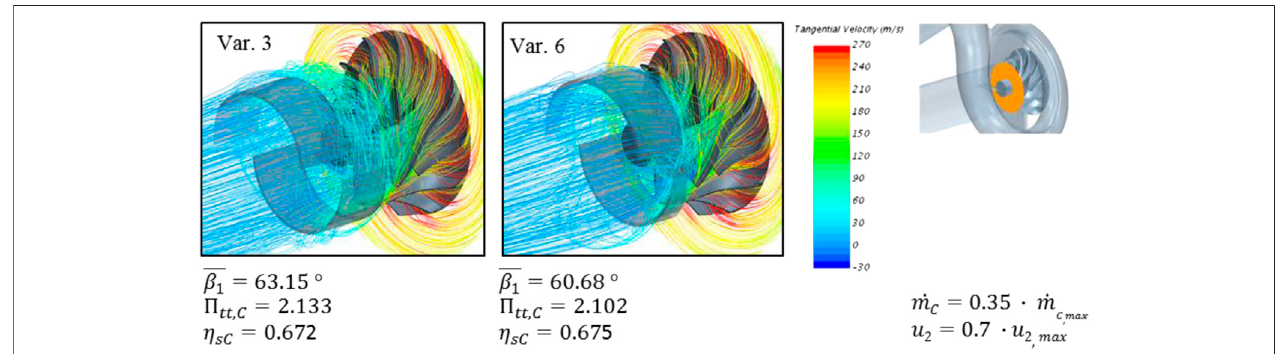
FIGURE 7 | CFD results for different Back fl ow Guiding Plate (BGP)